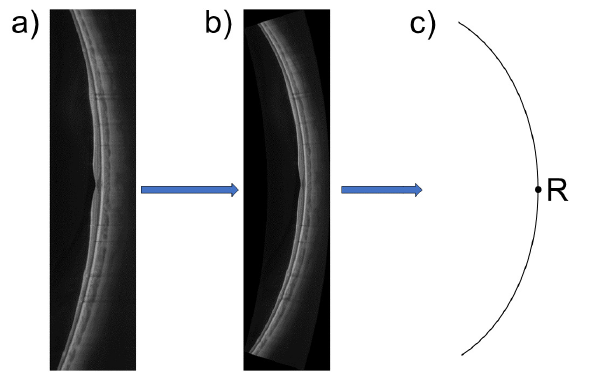
Figure 1. Process of retinal shape calculation from optical coherence tomography (OCT) imaging: ( a ) the original OCT scan; ( b ) the distortion-corrected OCT scan; ( c ) a circle is fitted to the retinal pigment epithelium (RPE) of the corrected scan image, and its radius is extracted for retinal shape estimation. The point “R” on this circle scheme is displayed for better reference to Figure